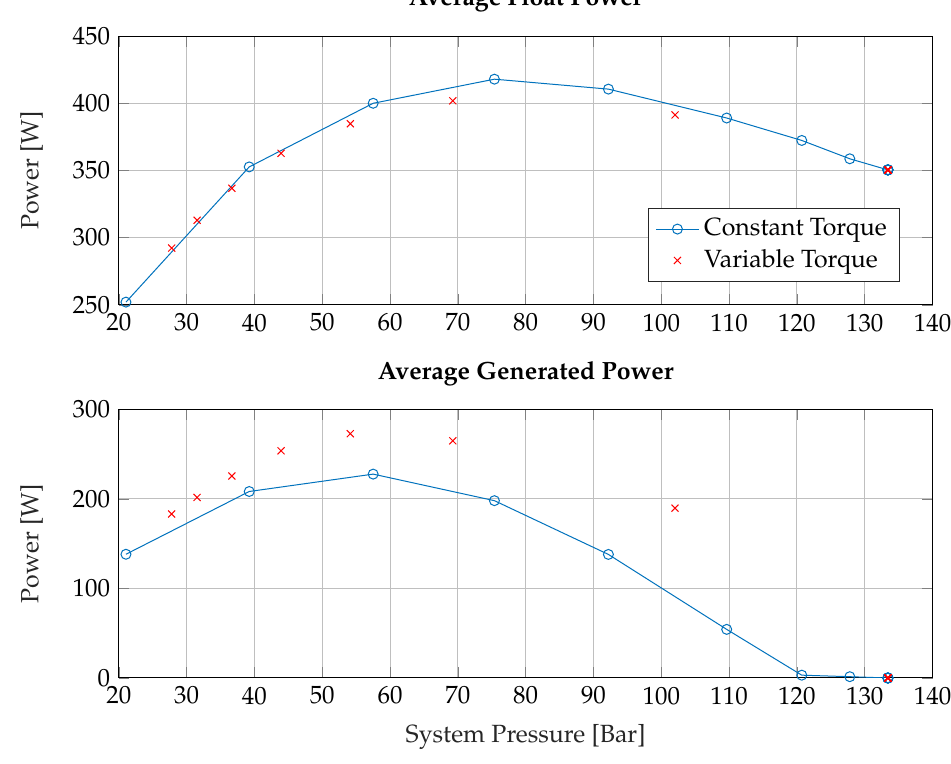
Figure 11. Sweep of motor torque control constants marked in red. Wave input: Irregular Wave. Where absorber power is the power applied upon the absorber, while generated power is the mechanical power generated by the hydraulic motor onto the